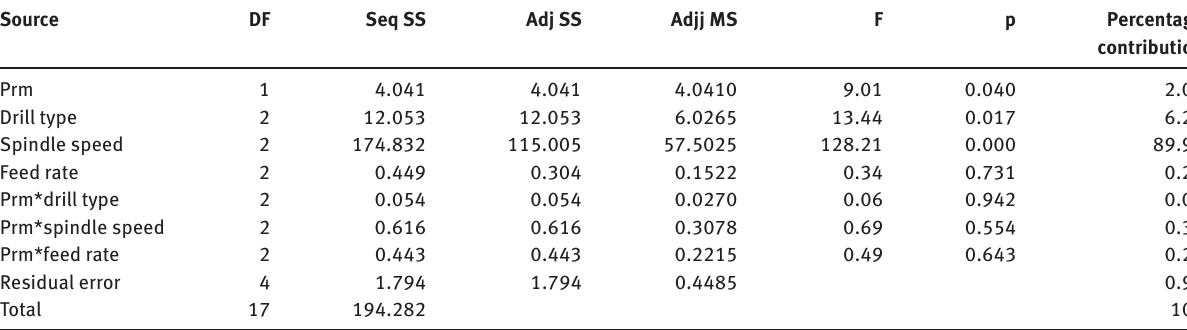
Table 10: ANOVA for S/N ratios for tool